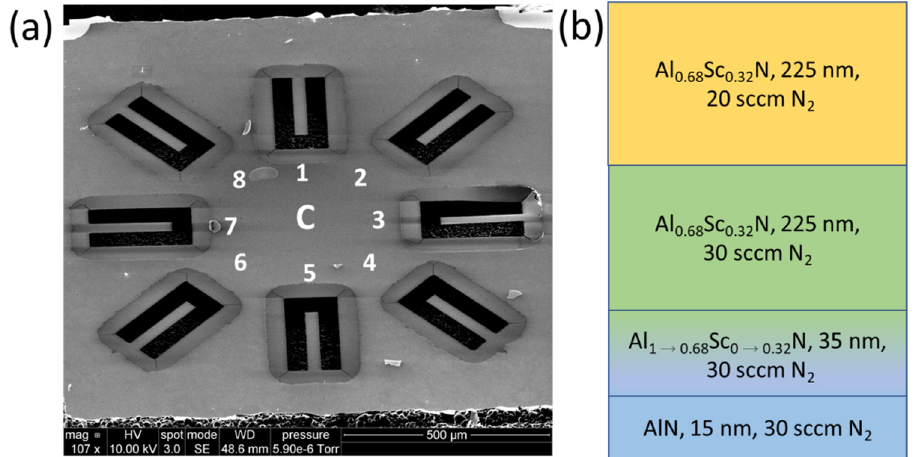
Figure 5. Graphics for multi-layer 500 nm PVD sputter-deposited Al 0.68 Sc 0.32 N film where the N 2 process gas flow is changed between two layers with 30 sccm utilized on the bottom and 25 sccm on the top layer, ( a ) 45-degree SEM image of the center die (C) fabricated from a 100 mm wafer. Each die has 8 released structures. ( b ) Stack-up of 2-layer film composed of a seed and gradient layer (Al 1 → 0.68 Sc 0 → 0.32 N) [3] to suppress AOGs and two equal thickness layers with different N 2 process gas flows designed to compensate for the native through-thickness stress gradient.